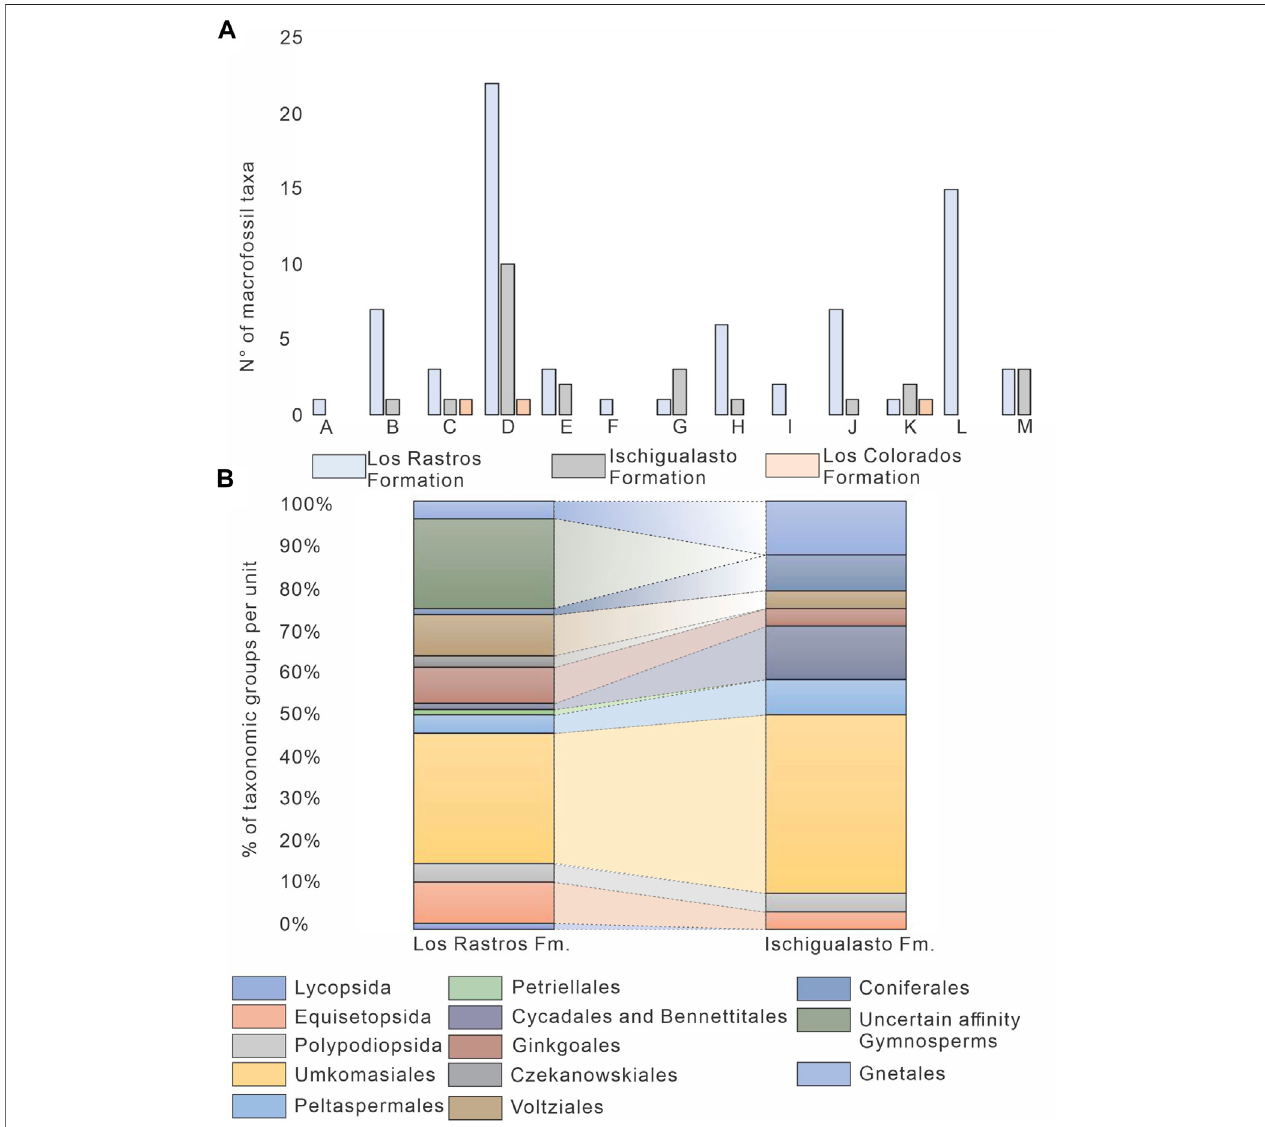
FIGURE 4 | Paleobotanical record of the Los Rastros, Ischigualasto, and Los Colorados formations. (A) . Number of macrofossil taxa per taxonomicgroup in each unit. A. Lycopsida, B. Equisetopsida, C. Polypodiopsida, D. Umkomasiales, E. Peltaspermales, F. Petriellales, G. Cycadales and Bennettitales, H. Ginkgoales, I. Czekanowskiales, J. Voltziales, K. Coniferales, L. Uncertain af fi nity Gymnosperms, M, Gnetales. (B) . Percentage of taxa of each taxonomic group registered in the Los Rastros and Ischigualasto formations.